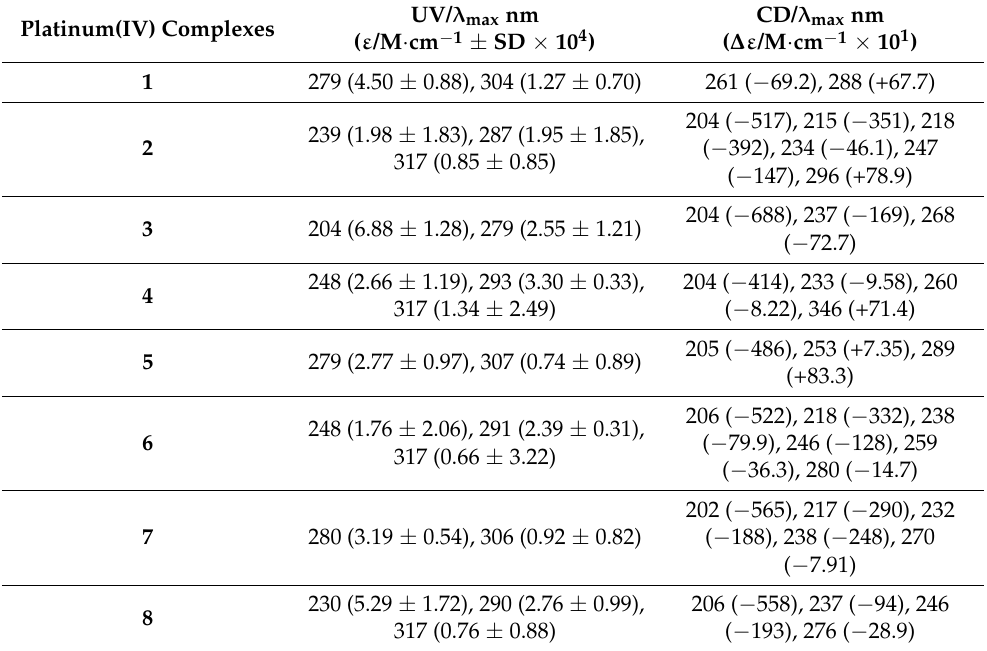
Table 3. Band maxima in the UV and CD spectra of 1 – 8 . Platinum(IV)